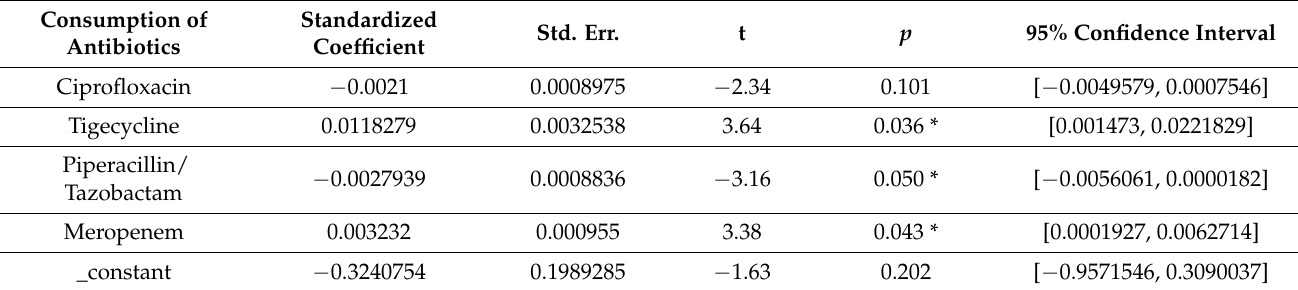
Table 5. Linear regression analysis of correlations between antibiotic resistance in Klebsiella and antibiotic consumption. Consumption of